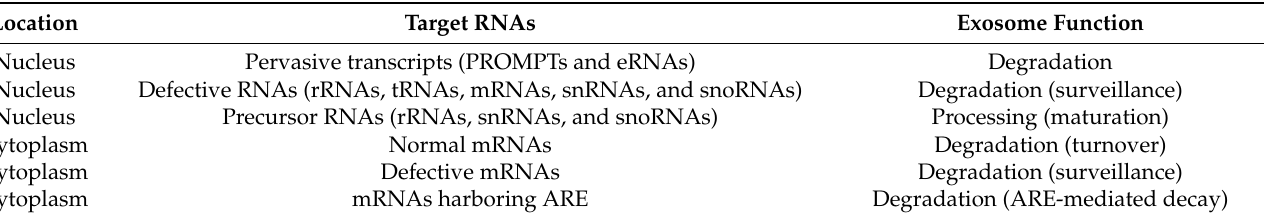
Table 1. Functions of the RNA exosome.